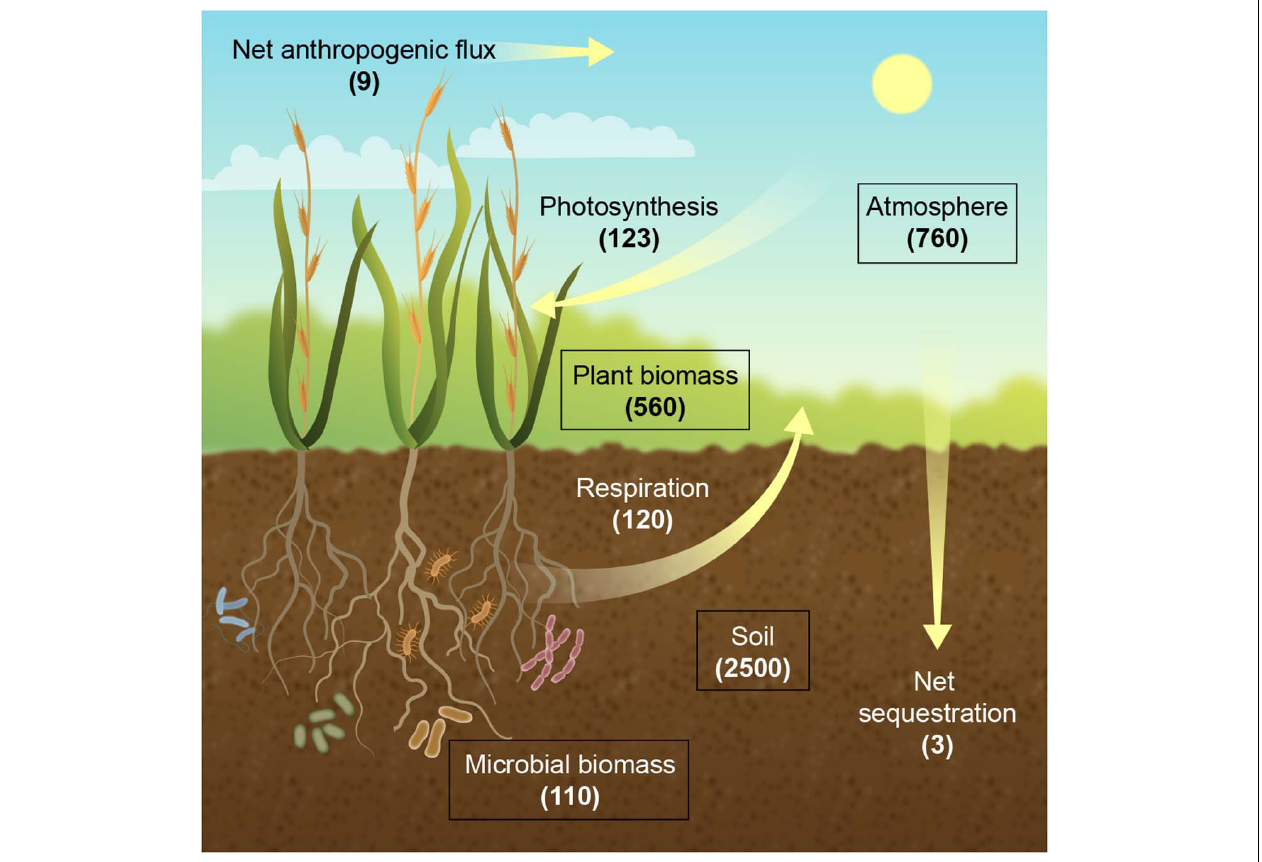
FIGURE 1 | The terrestrial carbon (C) cycle. Carbon stocks (boxes) are shown as gigatons (GT), and fluxes (arrows) are shown in GT per year. Respiration refers to accumulated plant and microbial